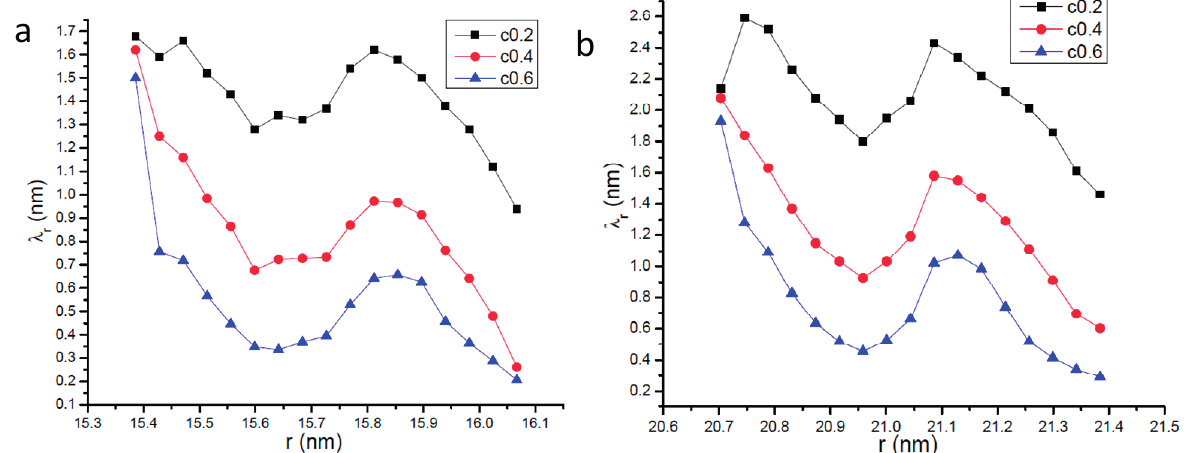
Figure 4. Profile of radial gas molecular mean free path in the zone 0.7 nm apart from the nanopore’s wall surface. ( a ) R = 16.06 nm; ( b ) R = 21.4 nm; and ( c ) R = 32.0